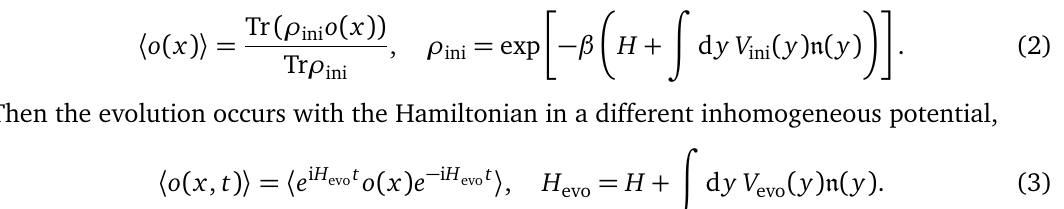
change of longitudinal